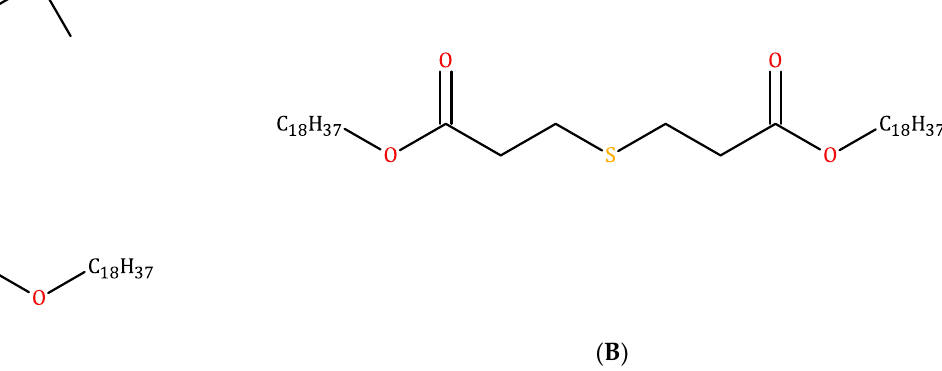
Figure 1. Chemical formula of antioxidants Irganox 1076 ( A ) and Irganox PS802 ( B ).